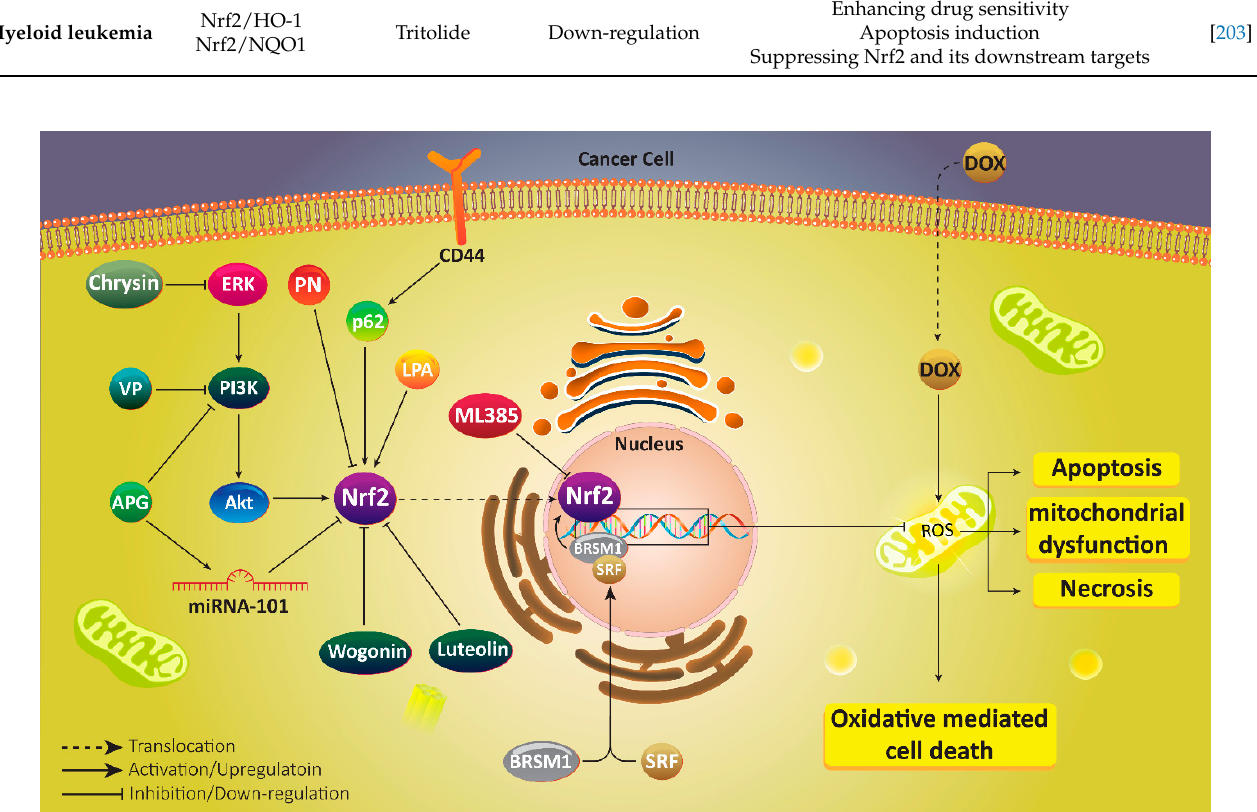
Figure 3. Nrf2 signaling in mediating DOX resistance of cancer cells. Suppressing Nrf2 signaling as a pro-survival pathway is associated with induction of apoptosis and necrosis in cancer cells, and their sensitivity to chemotherapy. Table 2. Activation/suppression of Nrf2 signaling and its association with DOX resistance/sensitivity.